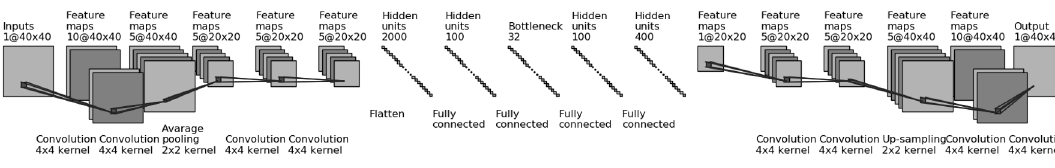
Figure 2 . Architecture of our autoencoder, see also ref.